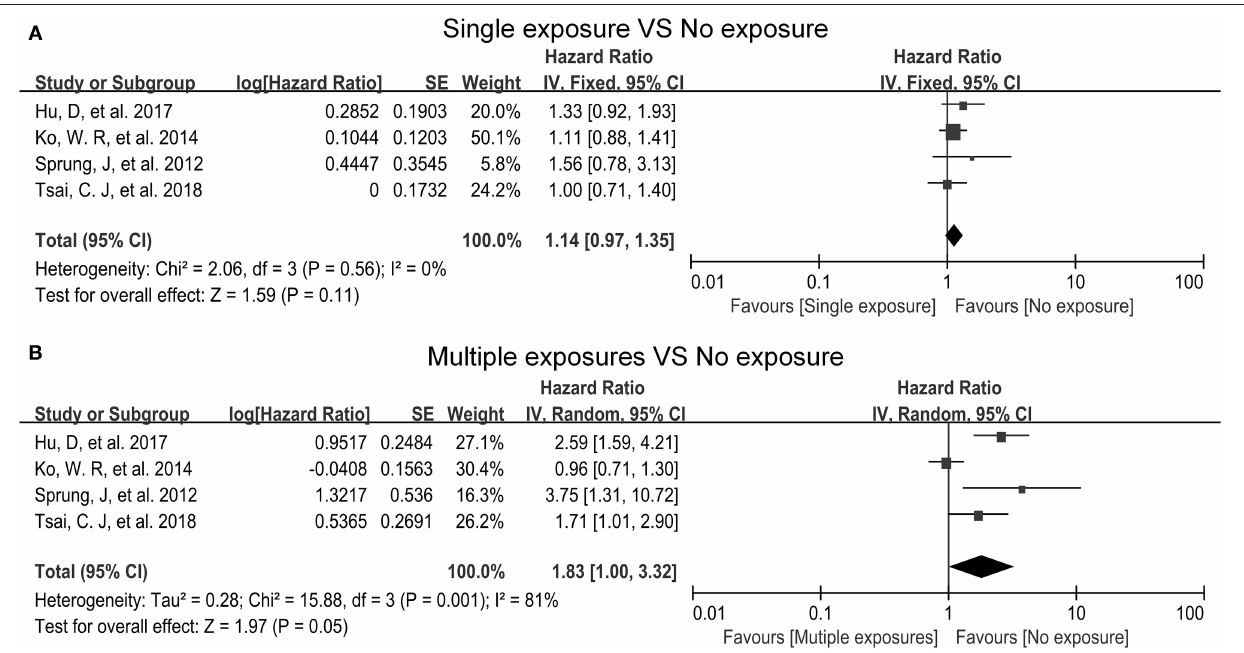
FIGURE 2 | Forest plots for association between exposure times and risk of attention-deficit hyperactivity disorder (ADHD). (A) Single exposure do not increase the risk of ADHD compared with no exposure. (B) Multiple exposures increase the risk of ADHD compared with no exposure.